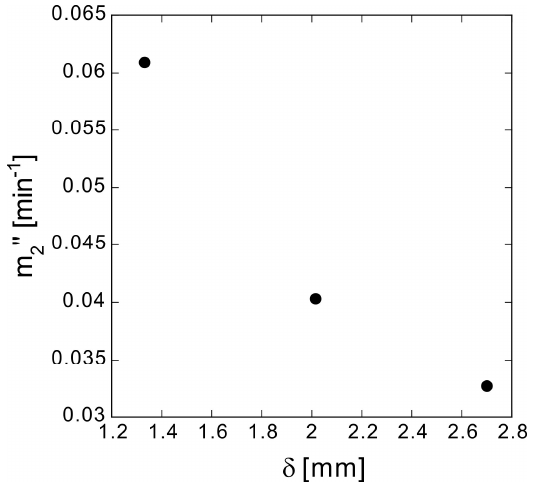
Figure 5. True elution rate constant m 2 ” at different sample thicknesses δ .